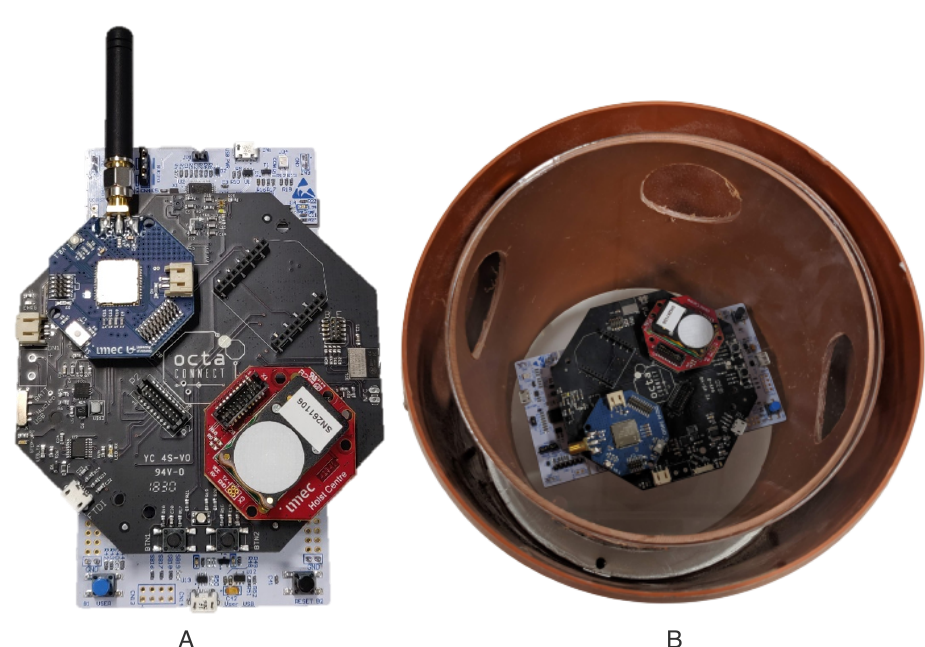
Figure 4. OCTA-Connect hardware modules that are used for the sensor setup. ( A ) Octa module setup with onboard temperature and humidity sensors. ( B ) Casing for the sensor setup deployed in the greenhouse with air-flow mechanism.